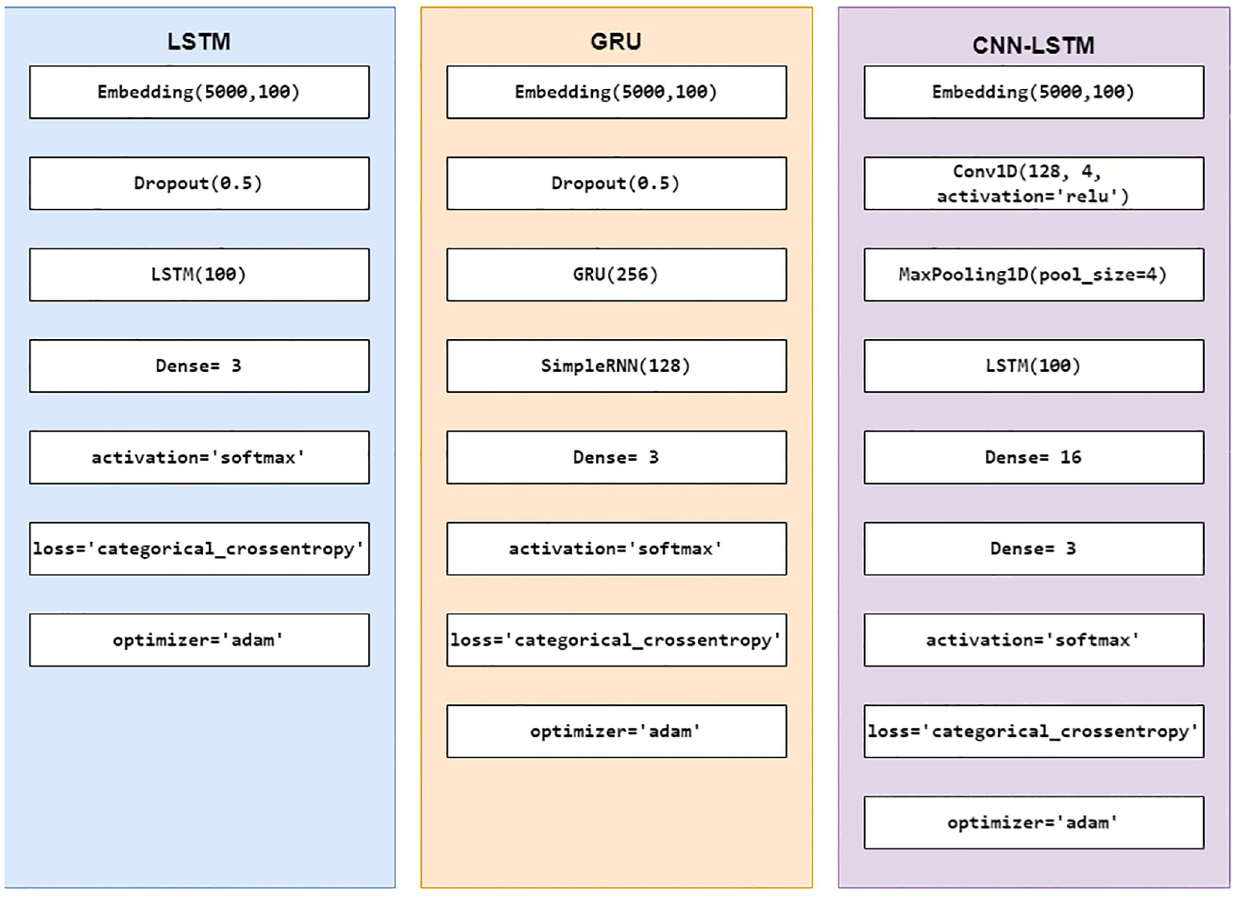
Fig 9. Layered architecture of deep learning models.